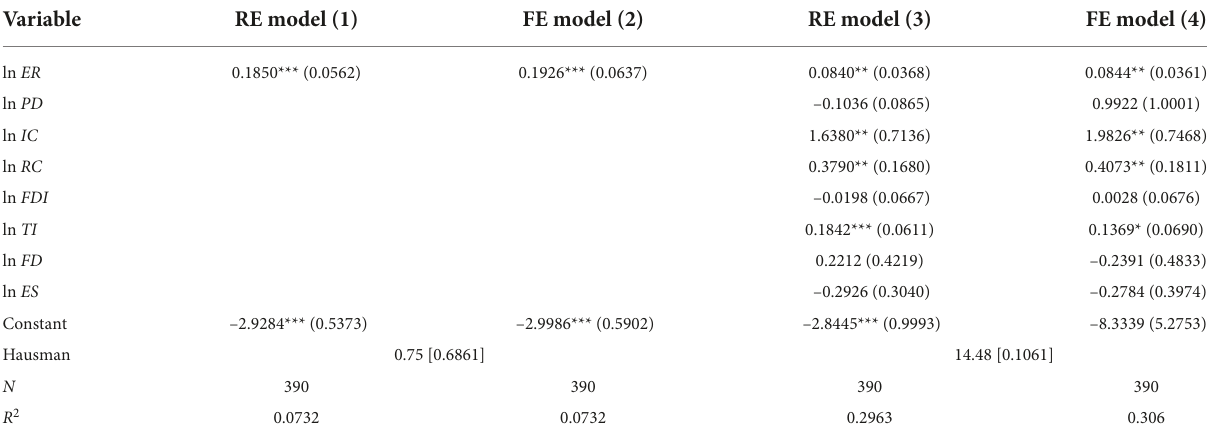
TABLE 2 Results of the impact of environmental regulation on industrial green